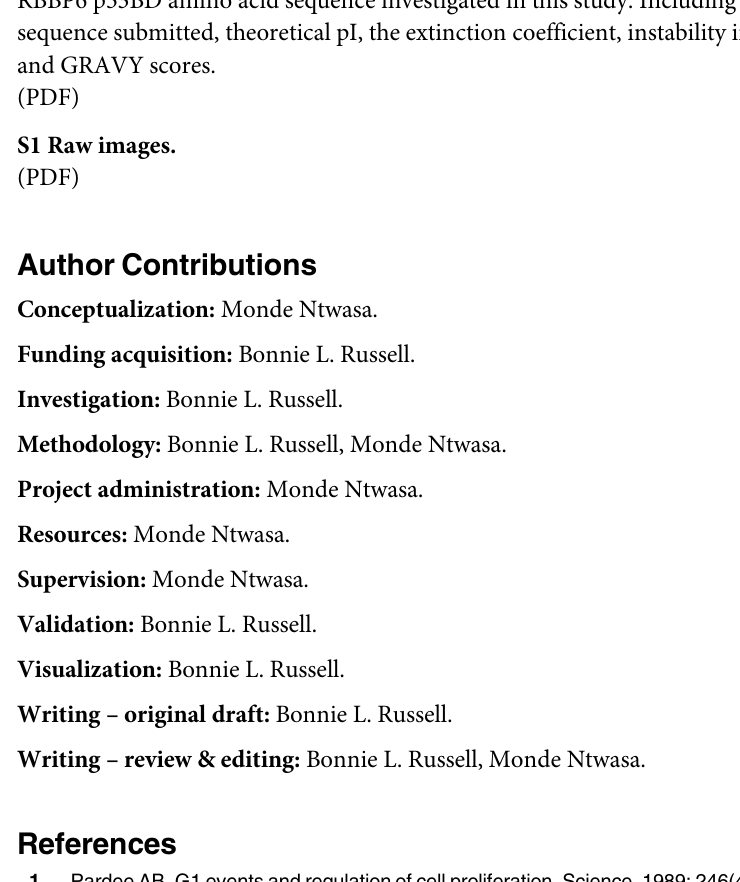
S1 Fig. ExPASy results for RBBP6 p53BD sequence. Results produced by ExPASy using the RBBP6 p53BD amino acid sequence investigated in this study. Including the amino